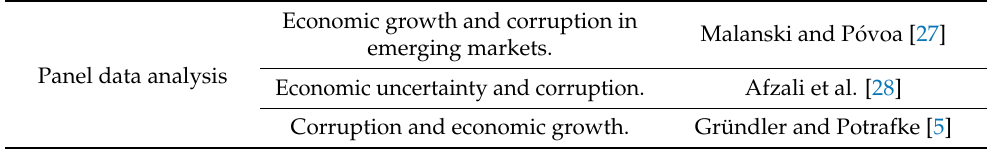
Table 3. Study on economic growth and